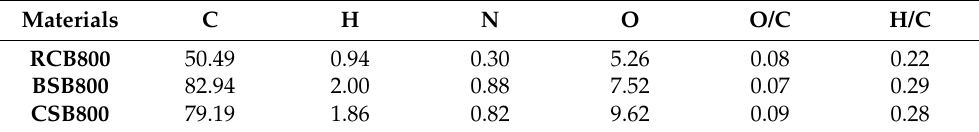
Table 1. Elemental analysis results of biochar and commercial carbon materials (at.%).